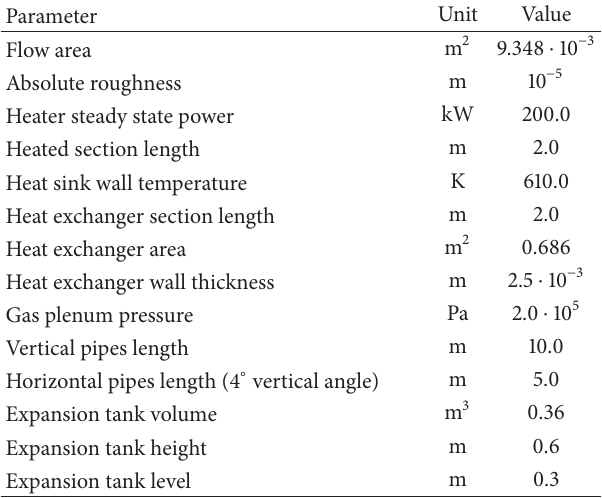
Table 4: Natural circulation system main